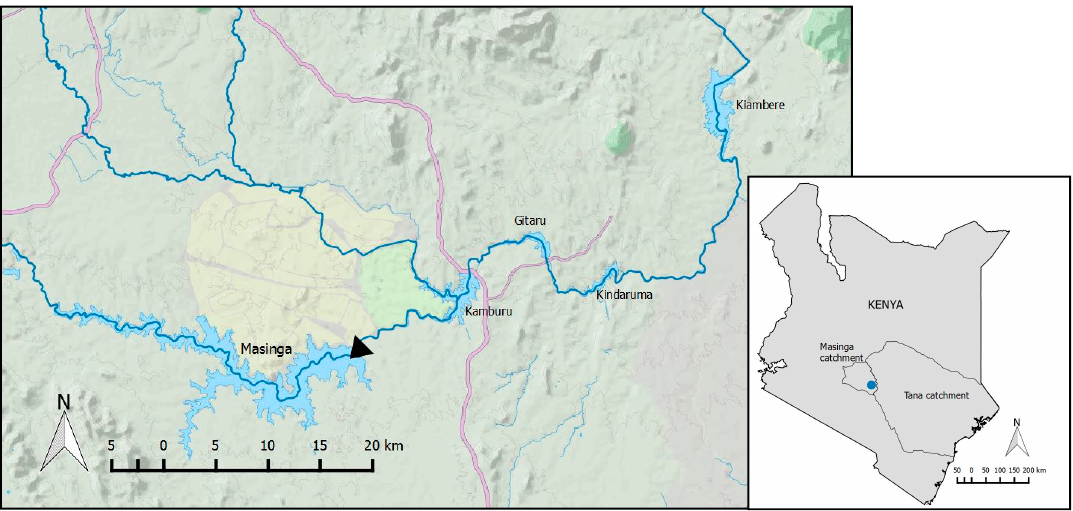
Figure 1. Masinga Reservoir and Dam location. Note: The blue dot shows the location within Kenya, and the black triangle denotes the dam location.